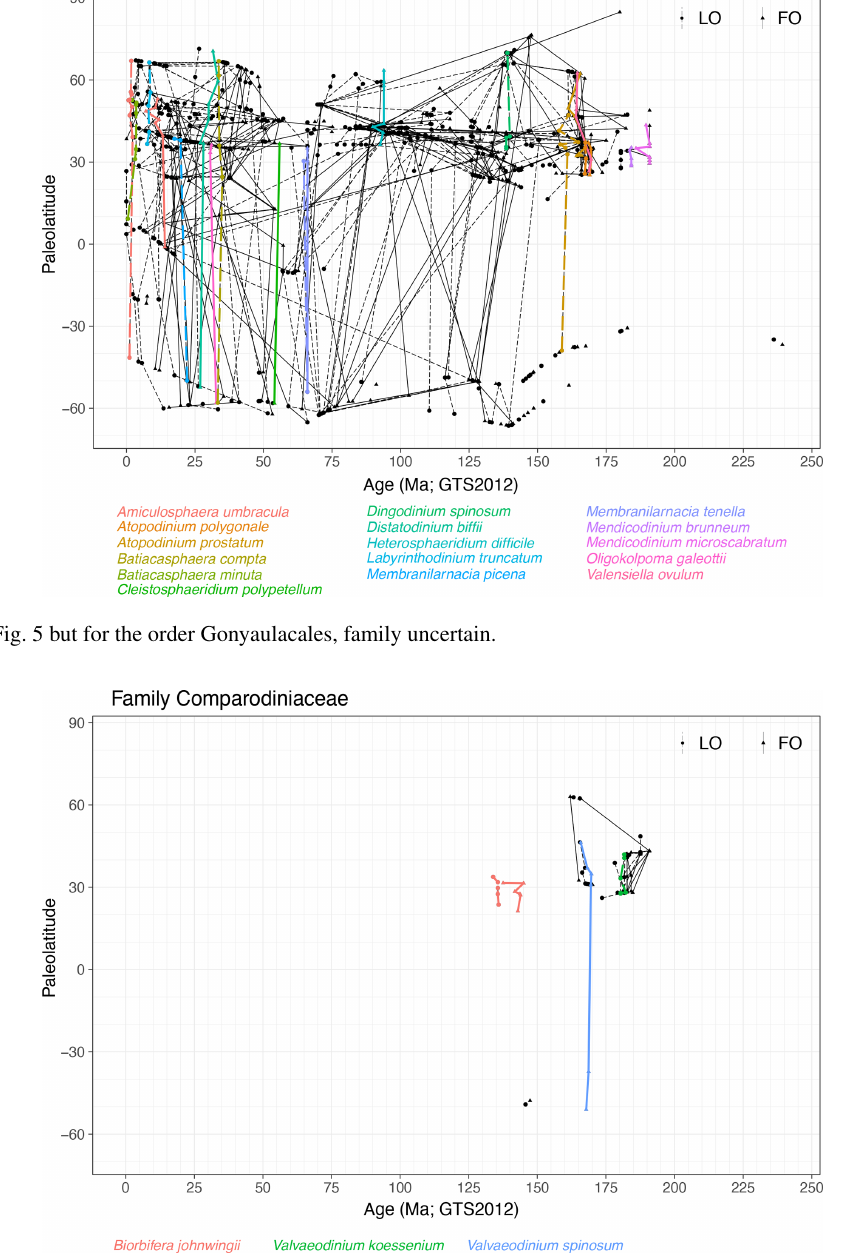
Figure 18. Same as Fig. 5 but for the family